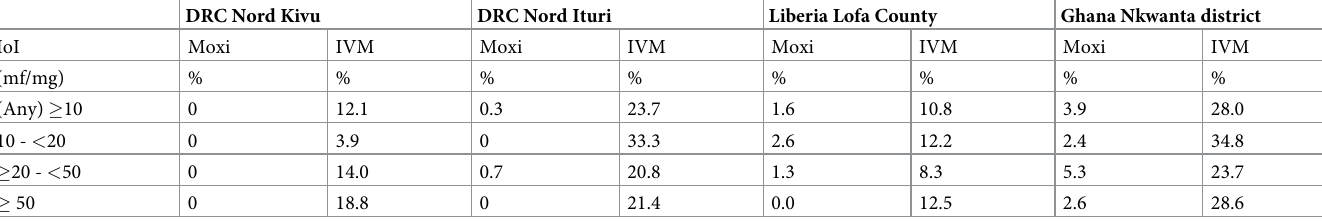
Table 7. Percentage of participants with ‘suboptimal response’ to moxidectin or ivermectin. DRC Nord Kivu DRC Nord